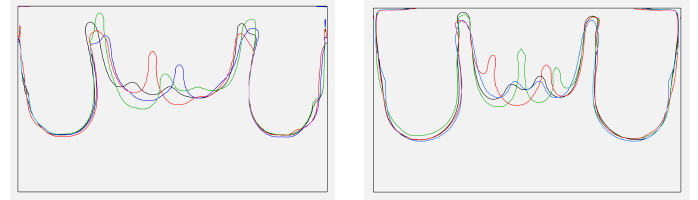
Figure 16. The interface position showing the initial Rayleigh–Taylor instability forming. A VOF iso-contour at 0.5 is represented by four different colours for four (out of ten) different simulations at N 50 resolution at the same time. Oil is on the left and water on the